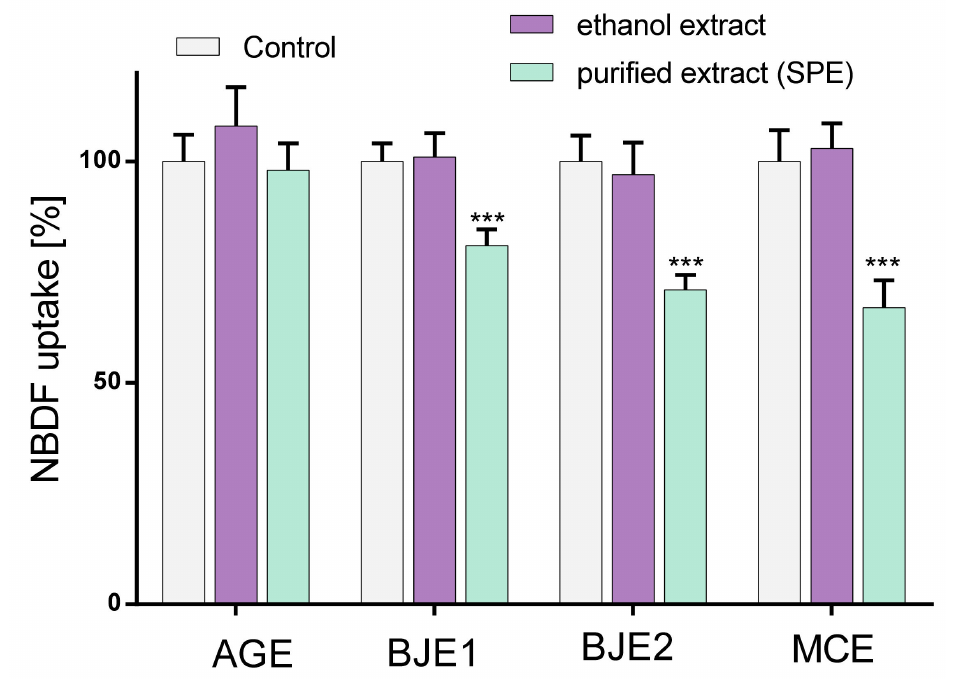
Figure 5. The influence of the extracts from Apium graveolens (AGE), Matricaria chamomilla (MCE), Brassica juncea 1/2 (BJE1/2) and the purified extracts (p) at 0.25 mg/mL concentration on NBD- fructose uptake by Caco-2 cells after 24-h exposure; cells were incubated with 100 µ M NBDF before fluorescence measurement; control cells were not exposed to any compound except vehicle; values are means ± standard deviations from at least three independent experiments, n ≥ 9; statistical significance was calculated versus control cells (untreated) with *** p ≤